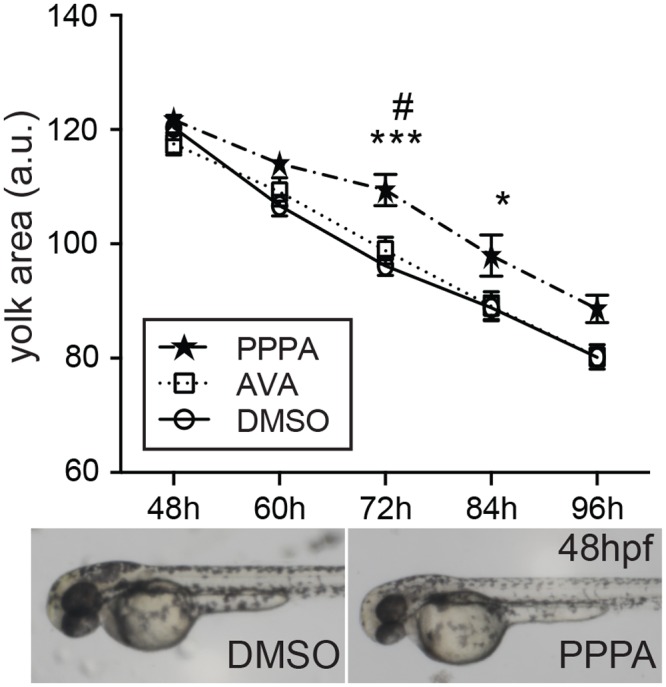
Delayed yolk consumption by yolk injection of PPPA.After the injection of PPPA, AVA or DMSO into the yolk at 3 hpf, embryos with grossly normal appearance at 24 hpf were subjected to yolk area measurement to estimate the yolk consumption. Yolk injection of PPPA resulted in significant larger yolk size at 72 and 84 hpf when compared to the DMSO group suggesting a delayed consumption of yolk content. *: P < 0.05, PPPA vs. DMSO; ***: P < 0.001, PPPA vs. DMSO; #: P < 0.05, PPPA vs. AVA